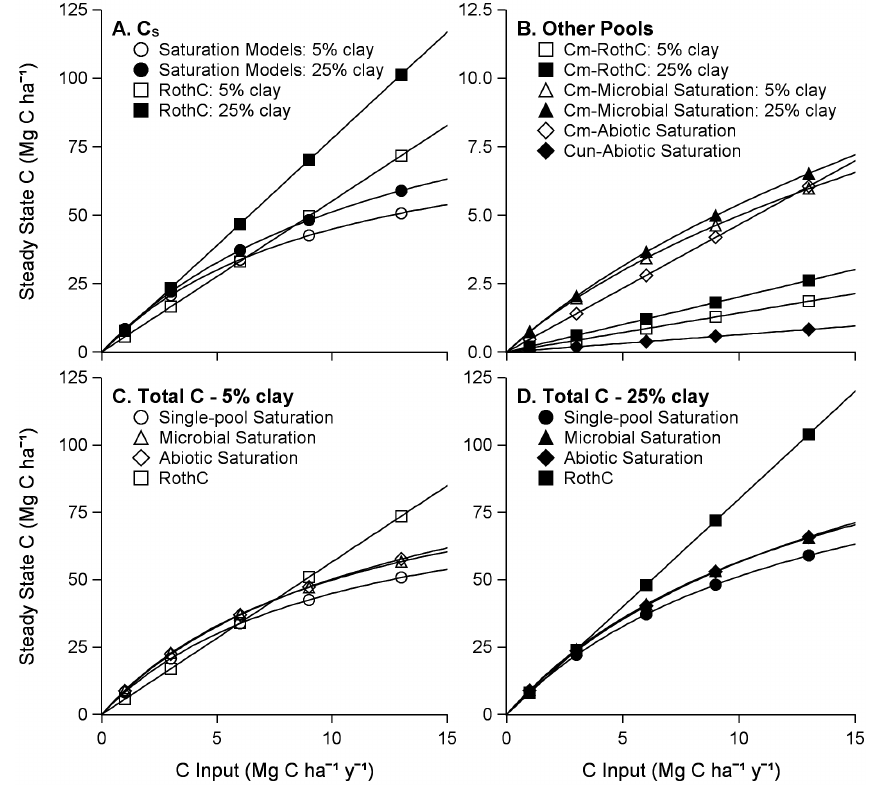
Figure 3. The relationship between C input level and the steady-state C level of various pools in each model for soils with contrasting clay concentration. (a) The C s pool of each model in soils with 0.05 and 0.25 clay concentration. (b) Other C pools in each model in soils with 0.05 and 0.25 clay concentration (note: the pools in the abiotic saturation model are not sensitive to clay concentration). (c, d) The total C pool size in soils with 0.05 clay concentration (c) and 0.25 clay concentration (d) .